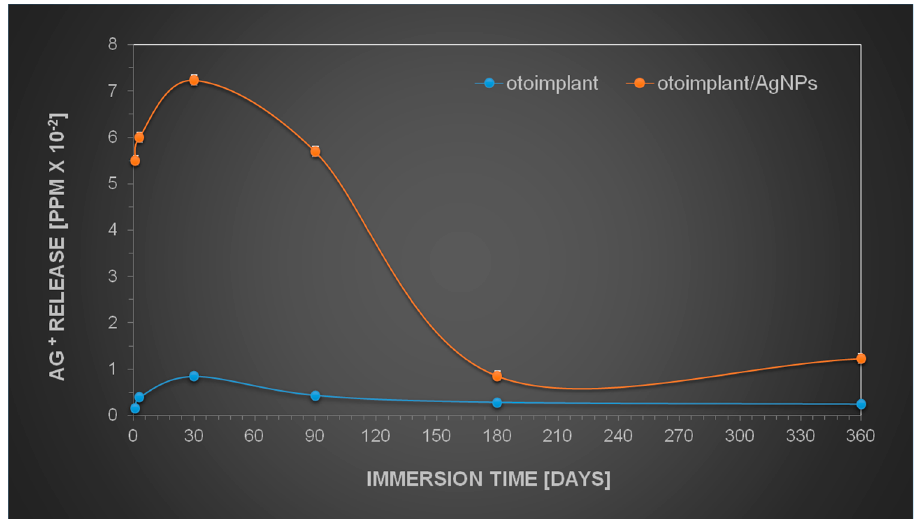
Figure 10. Kinetics of silver ions release during one-year incubation in UHQ water.